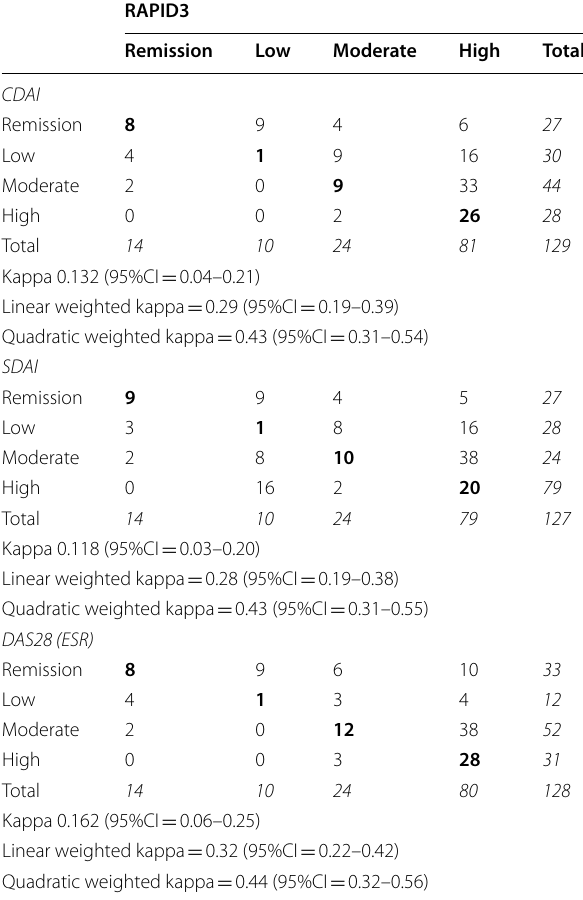
Table 3 Correlation between RAPID3 and the categories of composite disease activity indices (CDAI, SDAI e DAS28)